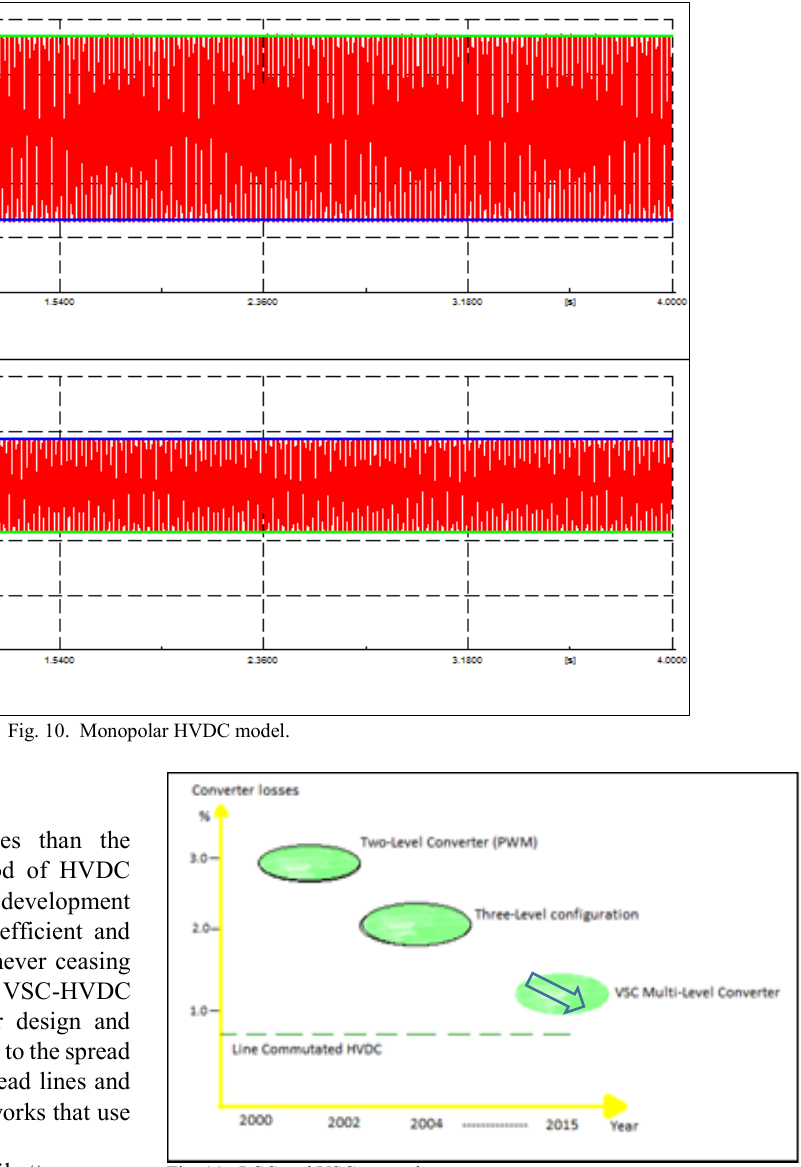
Fig. 11. LCC and VSC power